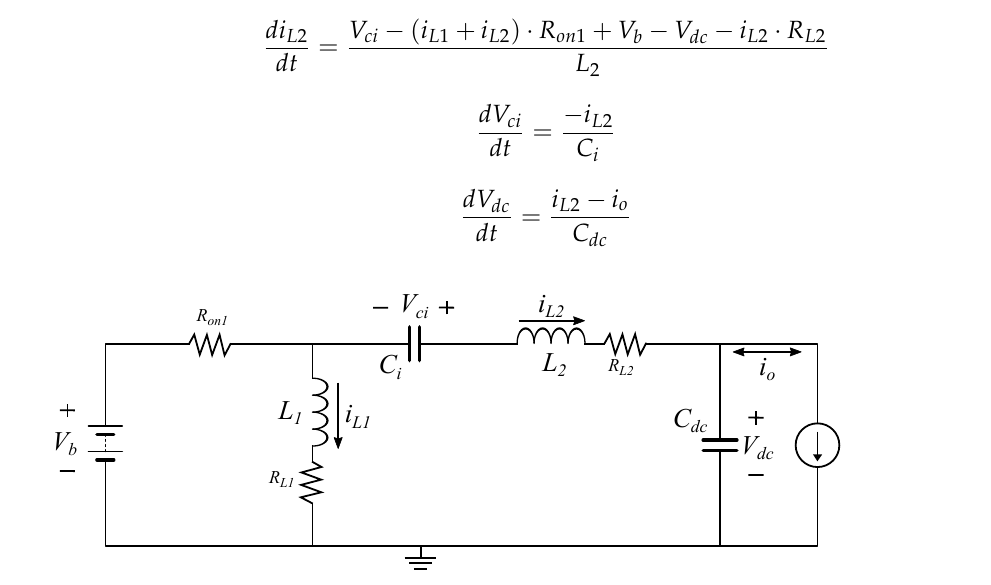
Figure 3. Charger/discharger operation for u = 1.